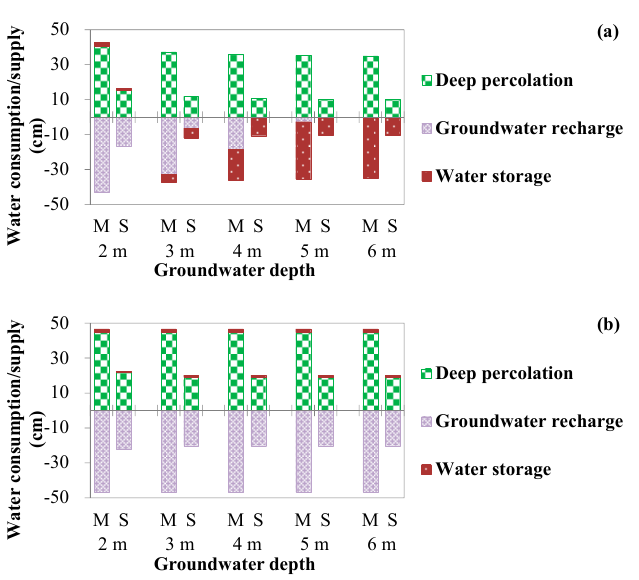
Figure 7. Soil water consumption and supply in buffer zone with the initial condition of ( a ) hydrostatic condition and ( b ) harvest condition (positive means supply, negative means consumption, M means maize and S means spring wheat).